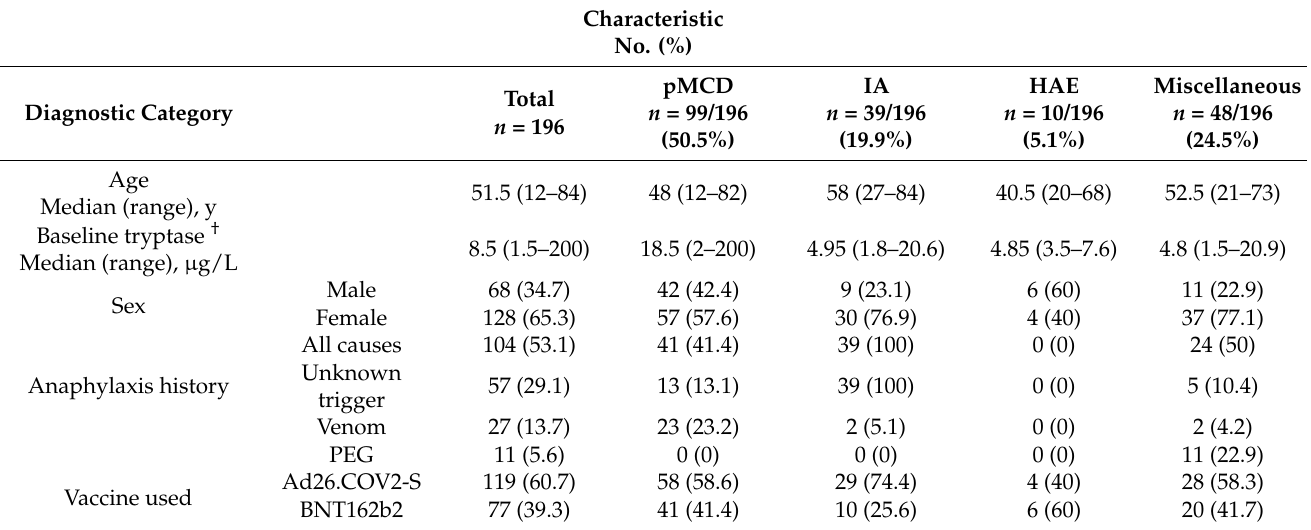
Table 1. Baseline population characteristics.